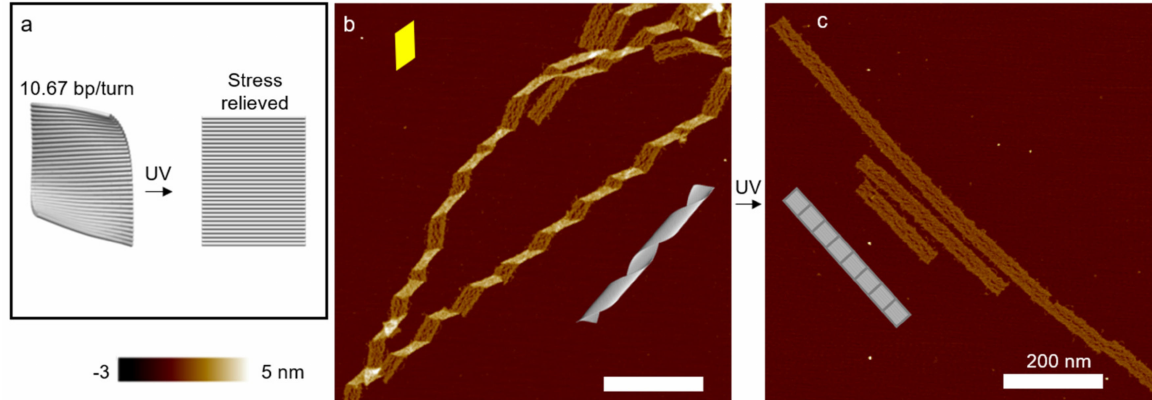
Figure 4. Effect of UV light on DNA structures. ( a ) Schematic of an origami rectangle. The tile is designed at 10.67 bp/turn, and the internal stress causes a global curvature. Moderate UVC or UVB radiation flattens the rectangular origami tile. ( b ) AFM image of polymerized DNA origami ribbons. The curvature of the individual tiles leads to a heavy twist of the ribbons. The parallelogram-shaped kinks indicate the right-handed twist (also see Figure 3). ( c ) AFM image of DNA ribbons after UVC irradiation (~2.5 kJ/m 2 ). The origami structures are completely flat. (Contents in this figure were previously published. Adapted with permission from [60]. Copyright (2017) American Chemical Society. Further permissions related to the material excerpted should be directed to the